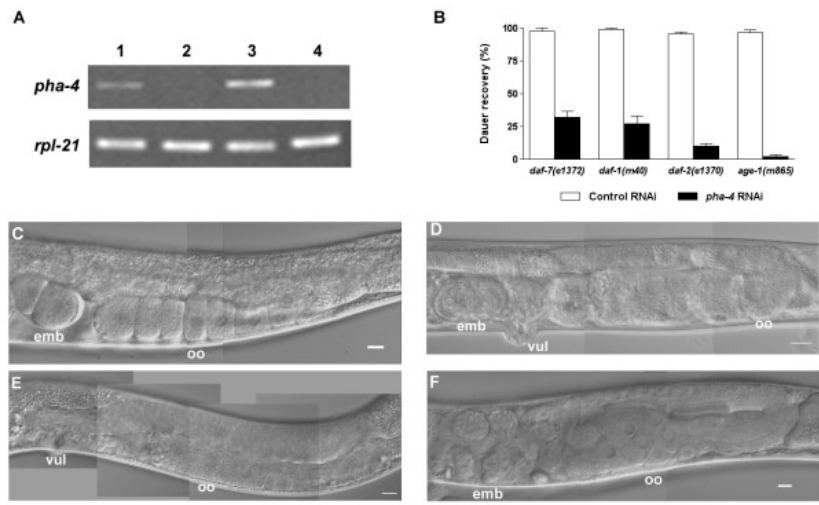
Figure 2. Example of medical figures with different modalities in a biomedical article [40].